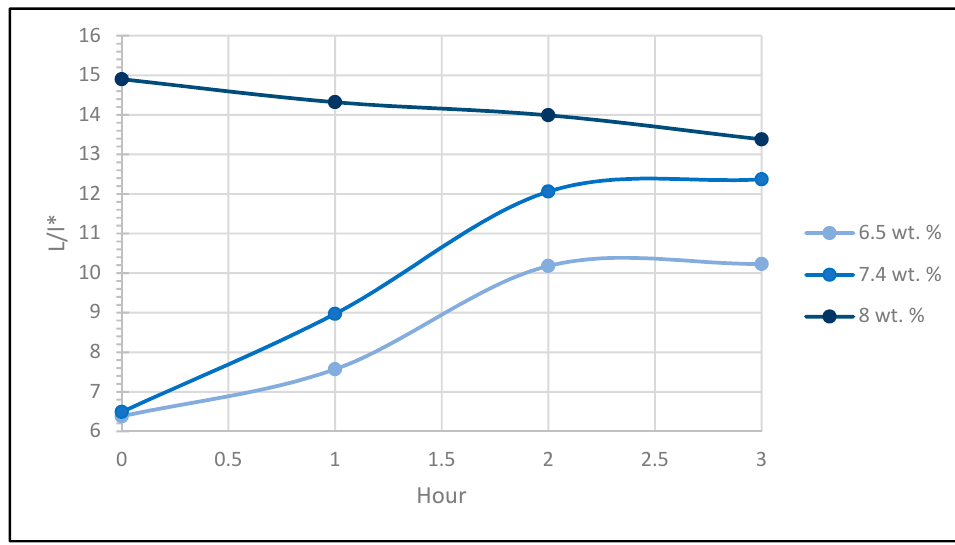
Figure 9. L/l* values for 6.5 wt %, 7.4 wt %, and 8 wt % CAPB and SLES, 15 wt % jojoba oil emulsions over 3-h period.